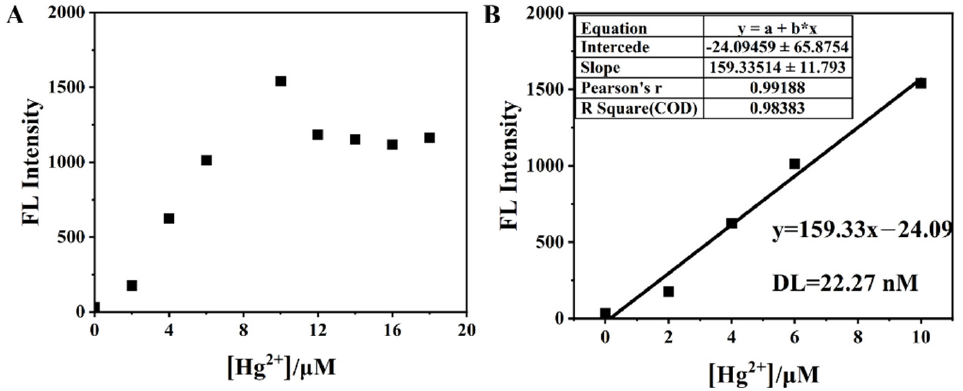
Figure 10. ( A ) Fluorescence intensity variation of BNEA (10 μ M) in 99% aqueous solution (V H2O :V DMSO = 99:1) with different mercury ion concentrations (0–2 equiv), ( B ) detection limit of BNEA for mercury ions.